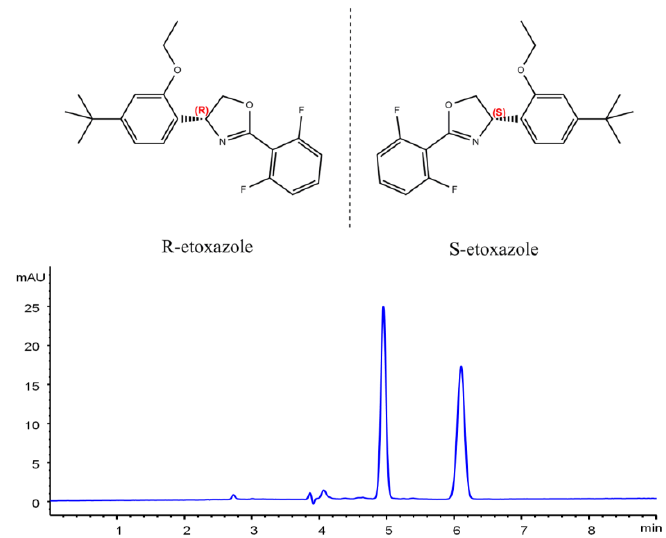
Figure 1. Chemical structure and chromatogram of etoxazole enantiomers on a Lux cellulose-3 column with an ACN/H 2 O ratio of 70/30 at 40 °C under reverse-phase conditions.